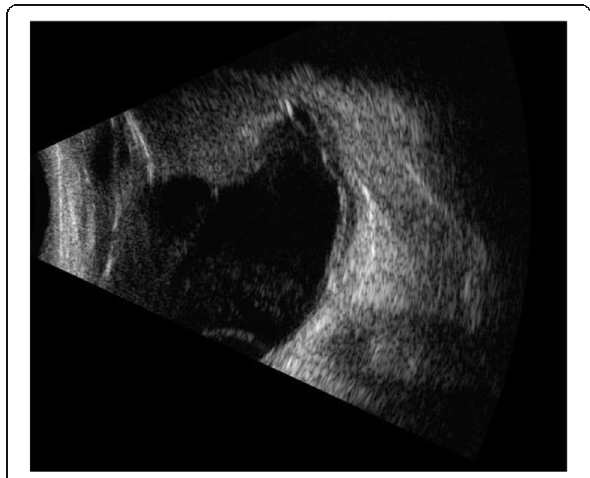
Fig. 4 B-scan ultrasonograpy of right eye before diagnosis vitrectomy showed vitreous opacity and retinal detachment with ring occupying lesion of ciliary body